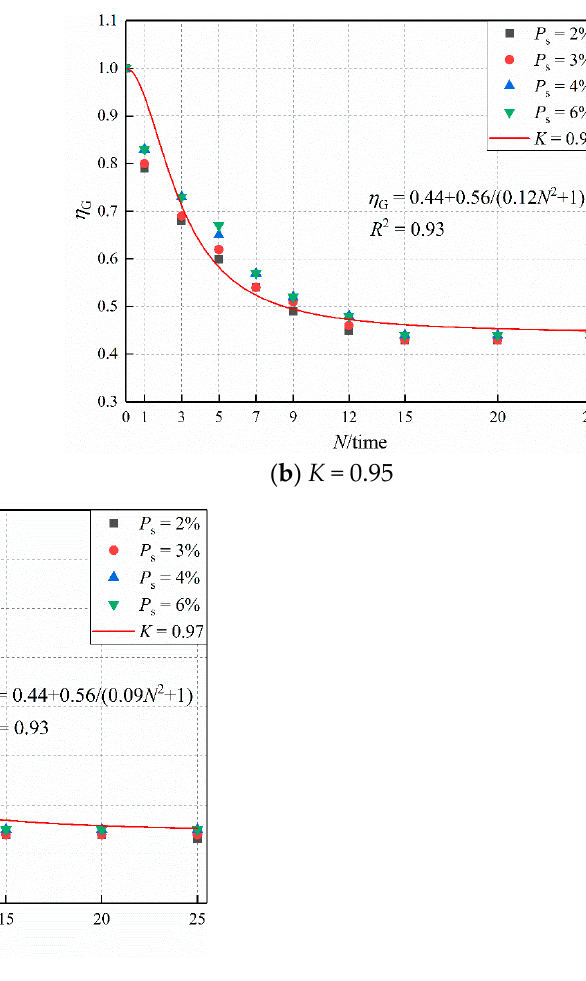
Figure 2. The relationship between η